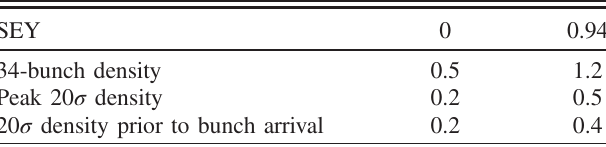
TABLE III. POSINST modeling results for EC densities N ( 10 11 m − 3 ) in the dipole regions of the ILC DR lattice. The first row shows the beam-pipe-averaged density at the end of a 34-bunch train. The second row shows the peak 20 σ density during the train passage. The third row gives the maximum 20 σ density just prior to the arrival of any bunch. SEY